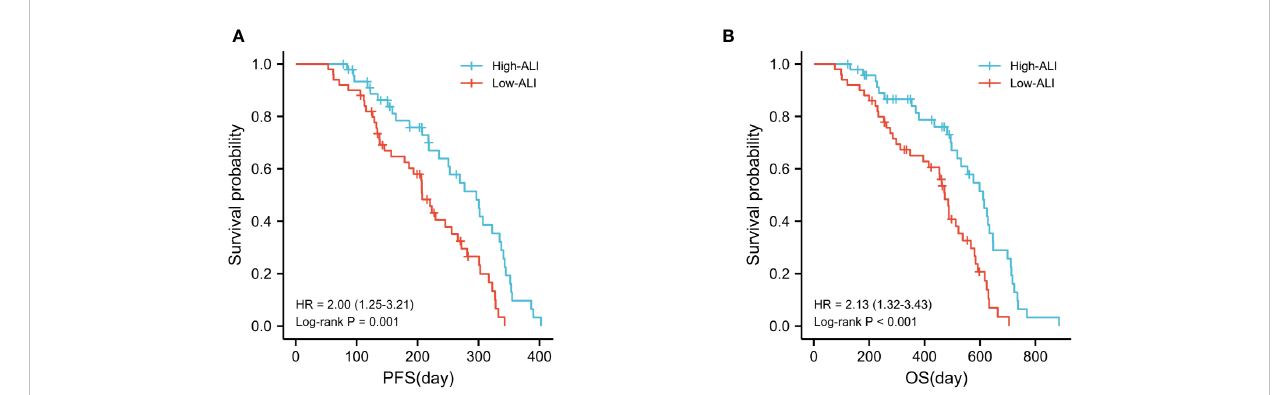
FIGURE 2 Kaplan – Meier analysis of PFS (A) and OS (B) in relation to the ALI in